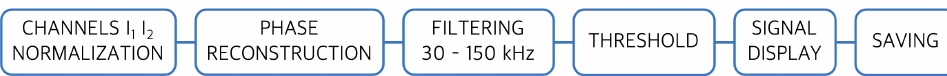
Figure 5. LabVIEW SW steps schematic implemented for the FOS demodulation algorithm.